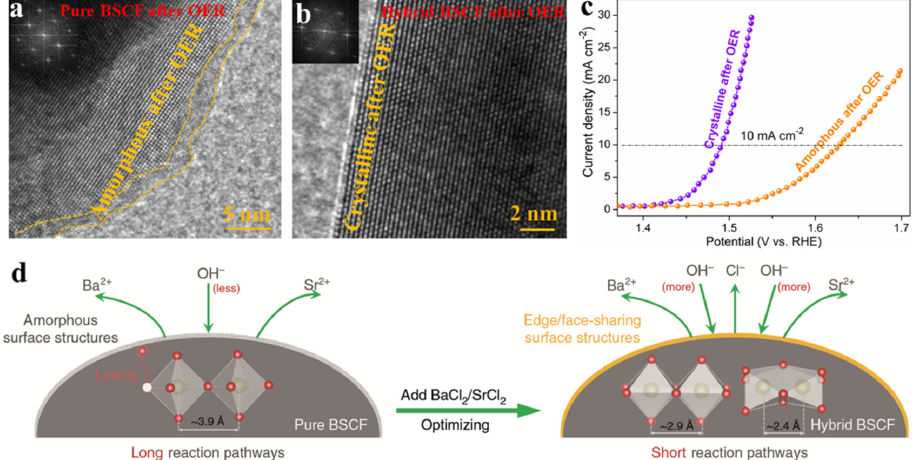
Figure 4. HRTEM images of the ( a ) pure-phase BSCF and ( b ) hybrid BSCF after OER tests. ( c ) LSV curves of the pure-phase BSCF and hybrid BSCF for the OER. ( d ) Schematic illustrations showing control of the surface change. Reproduced with permission [67]. Copyright 2020, Nature Publishing Group.